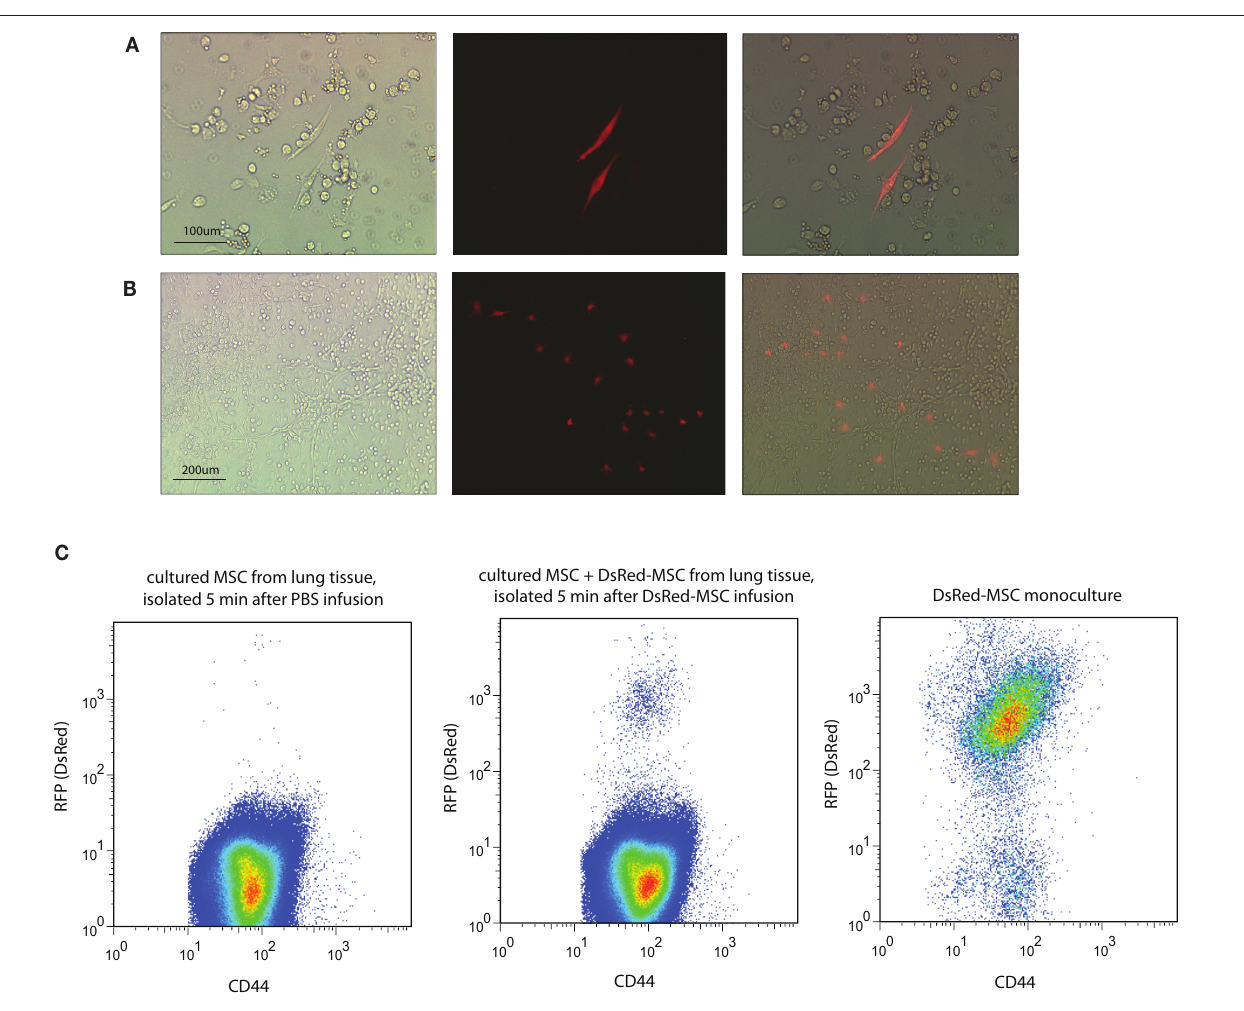
from lung tissue 5min after DsRed-MSC infusion cultured for 7 days revealed a distinct population of CD44 + DsRed-MSC (middle plot), while in cultures of PBS treated animals no DsRed-MSC were present (left plot). Mono-cultures of DsRed-MSC served as gating control (right plot). Five animals were included per group. Representative data shown.